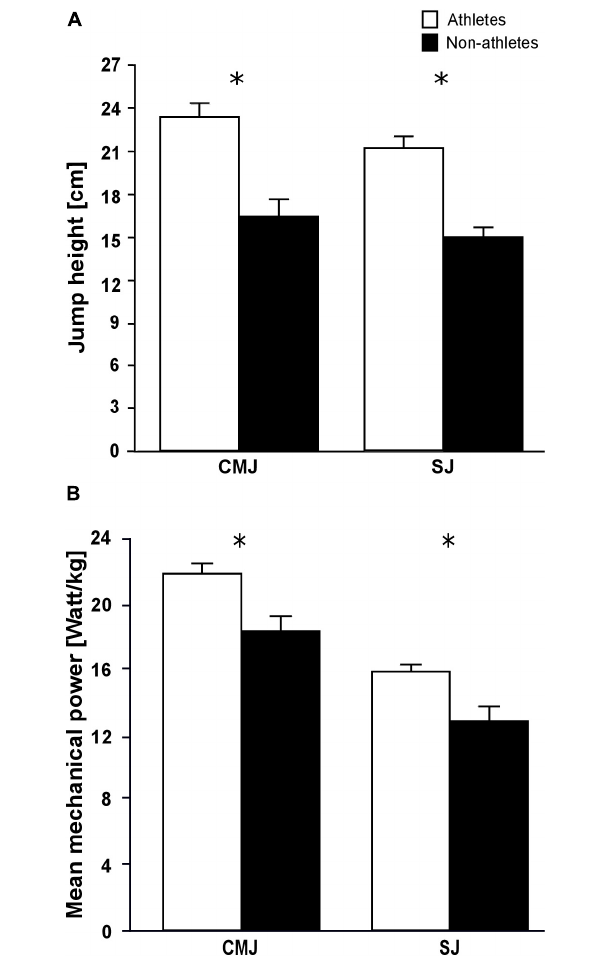
FIGURE 1 | Mean values and standard error (error bars) of (A) jump height and (B) mean mechanical power during the propulsion phase of preadolescent athletes and non-athletes during the countermovement (CMJ) and squat jump (SJ). ∗ Significant difference between athletes and non-athletes p < 0.05.